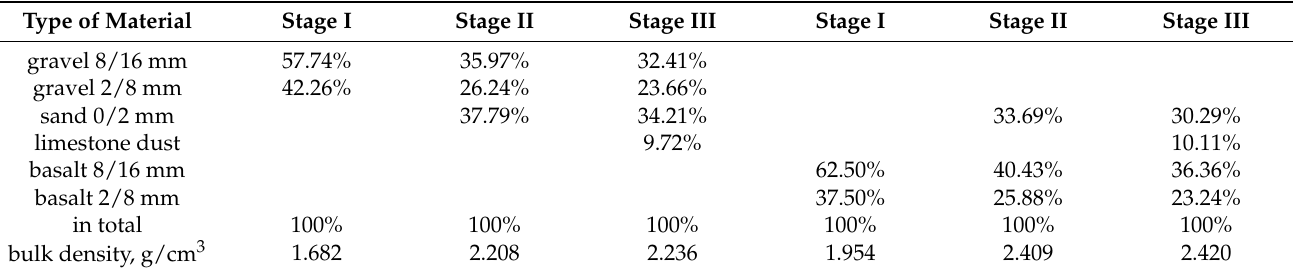
Table 8. The compositions of mineral mixes determined on the basis of maximum bulk